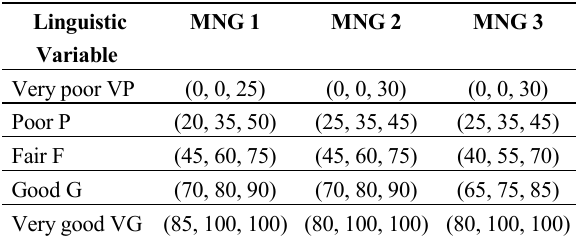
Table 3. The subjective fuzzy scale and linguistic expression